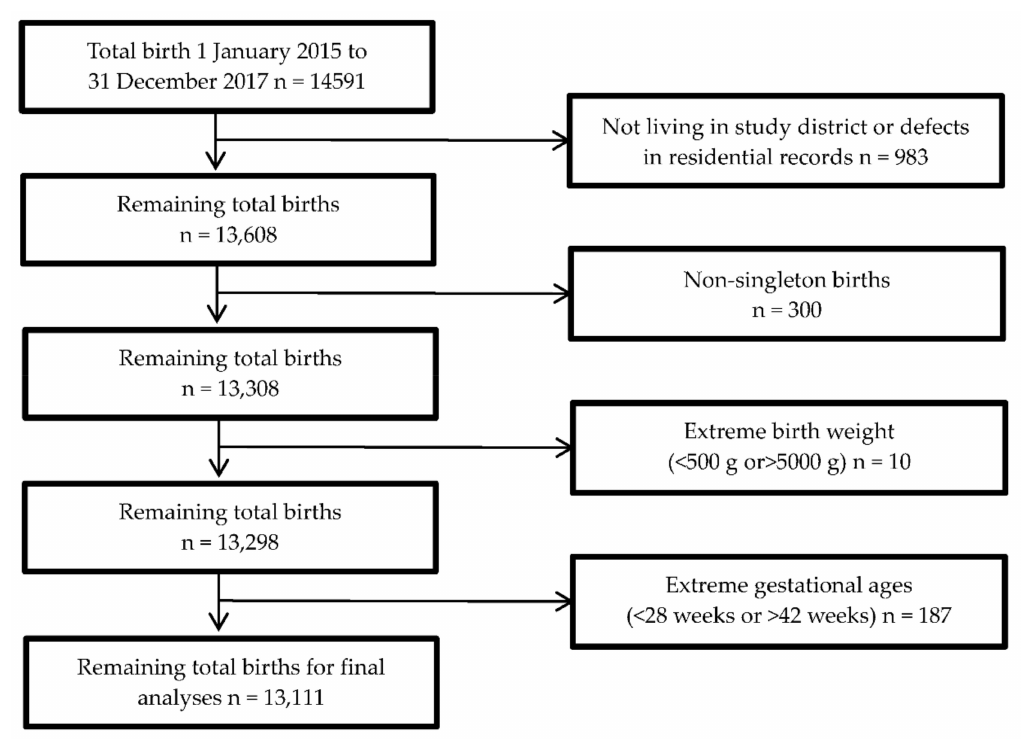
Figure 1. Exclusion process of the birth data used in the analyses.